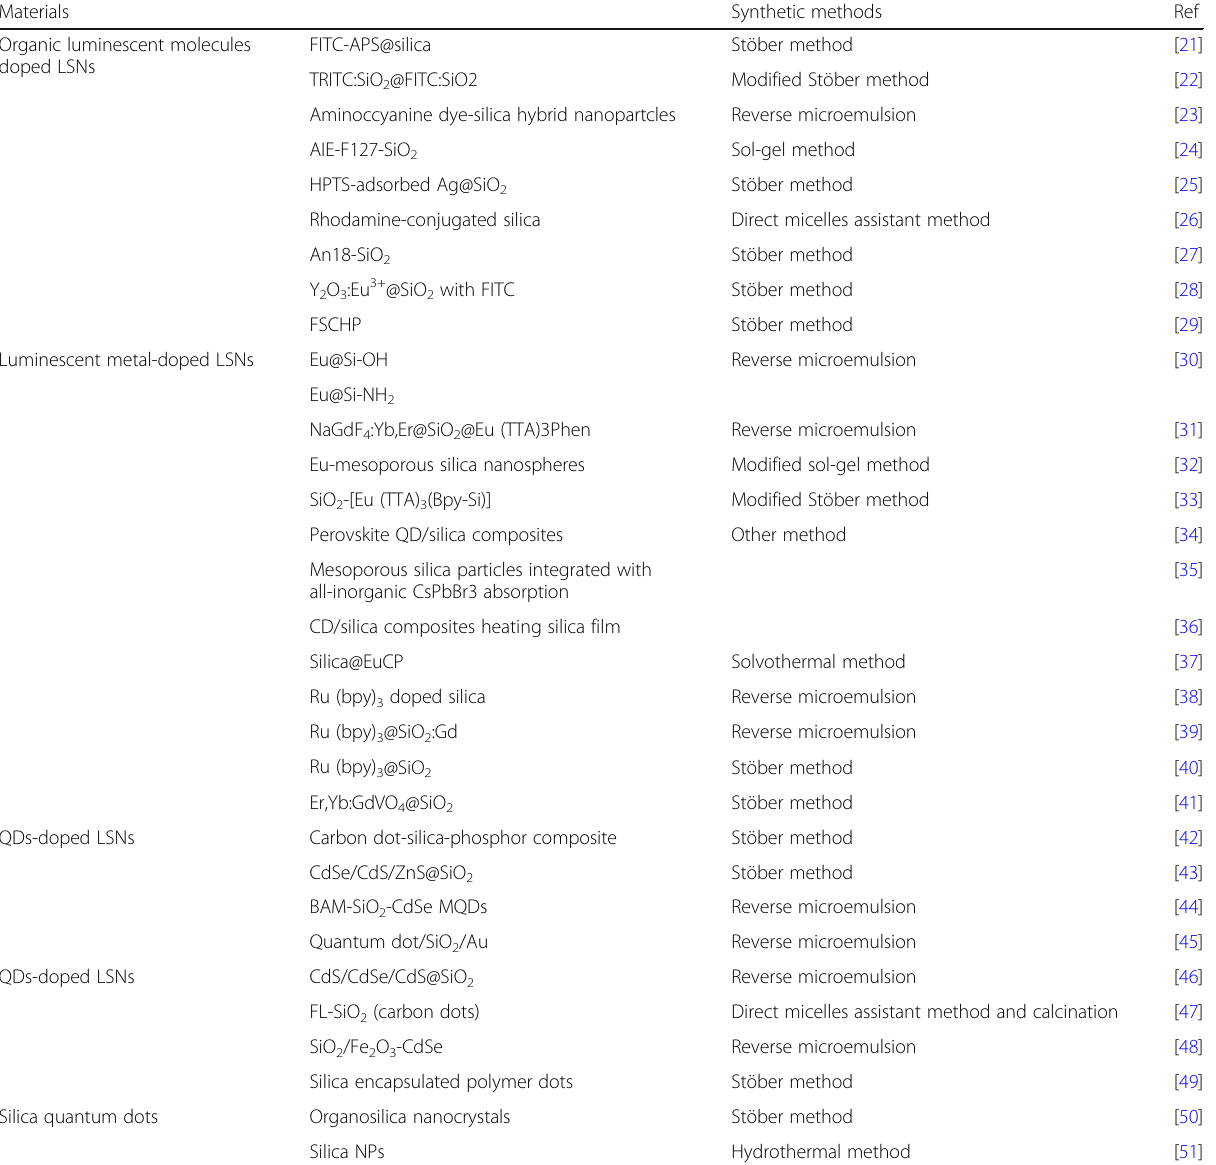
Table 1 The composition and synthetic methods of reported LSNs Materials Synthetic methods Organic luminescent molecules doped